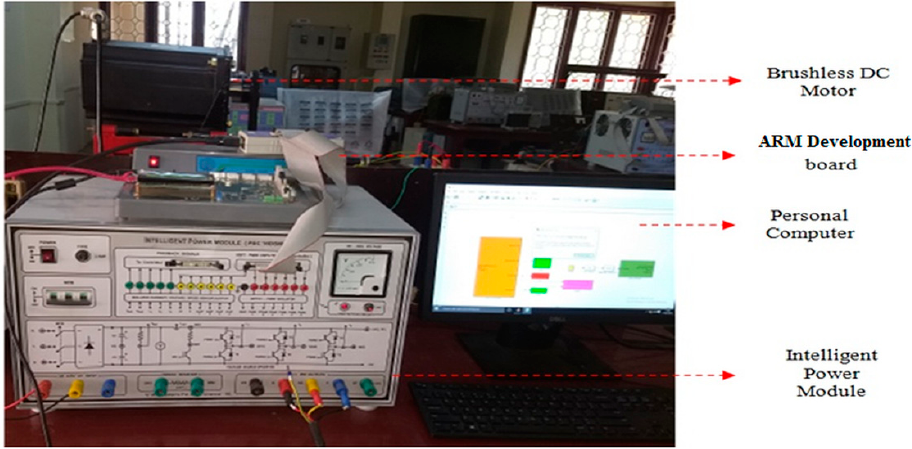
Figure 12. Electronics 2020 , 9 , x FOR PEER REVIEW